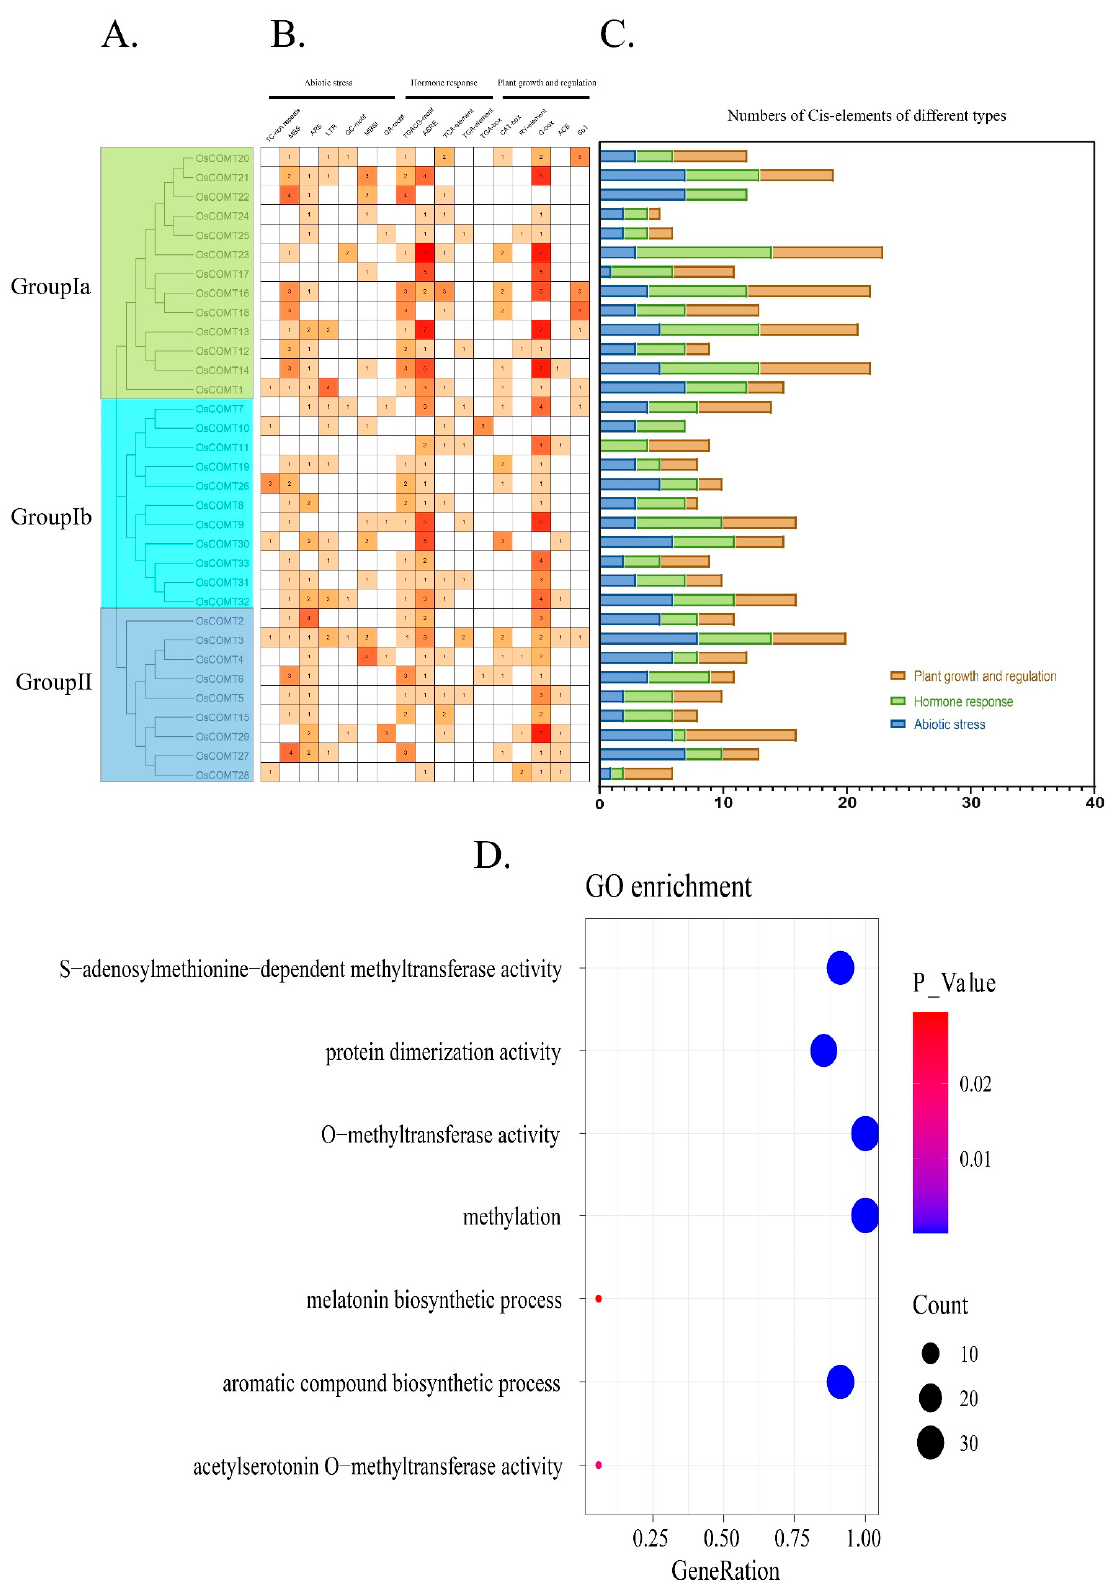
Figure 5. ( A ) Phylogenetic tree of OsCOMTs . ( B ) Cis-acting elements heatmap of OsCOMTs . ( C ) Histograms of different colors represent different types of elements. ( D ) GO enrichment analysis of OsCOMTs